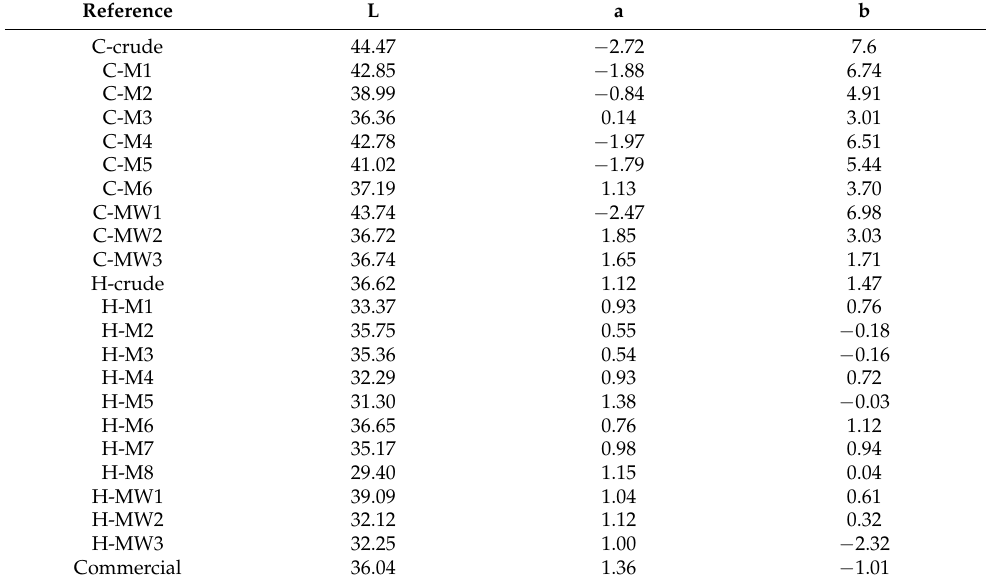
Table 2. L*a*b* colorimetric coordinates of different pigments